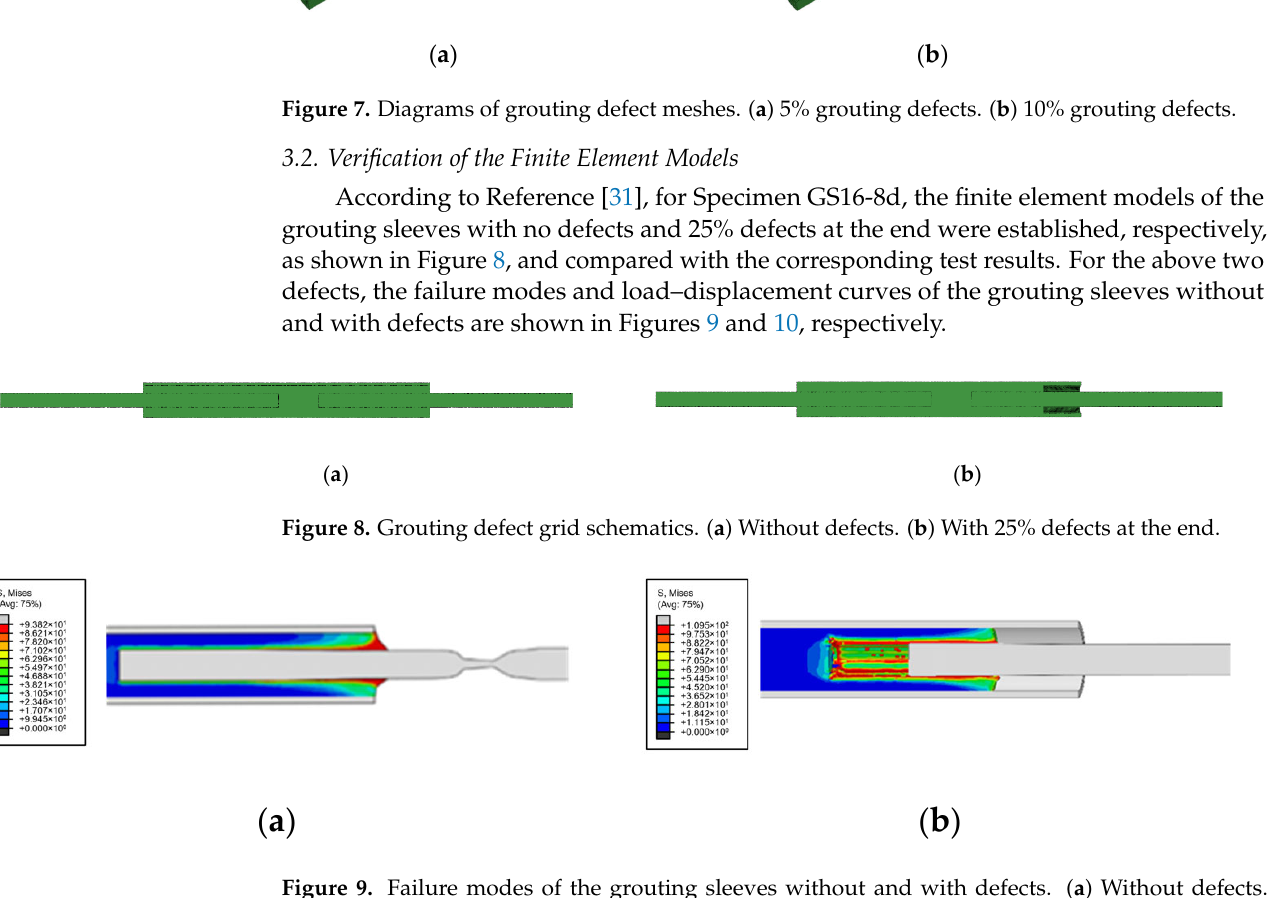
Figure 7. Diagrams of grouting defect meshes. ( a ) 5% grouting defects. ( b ) 10% grouting defects.